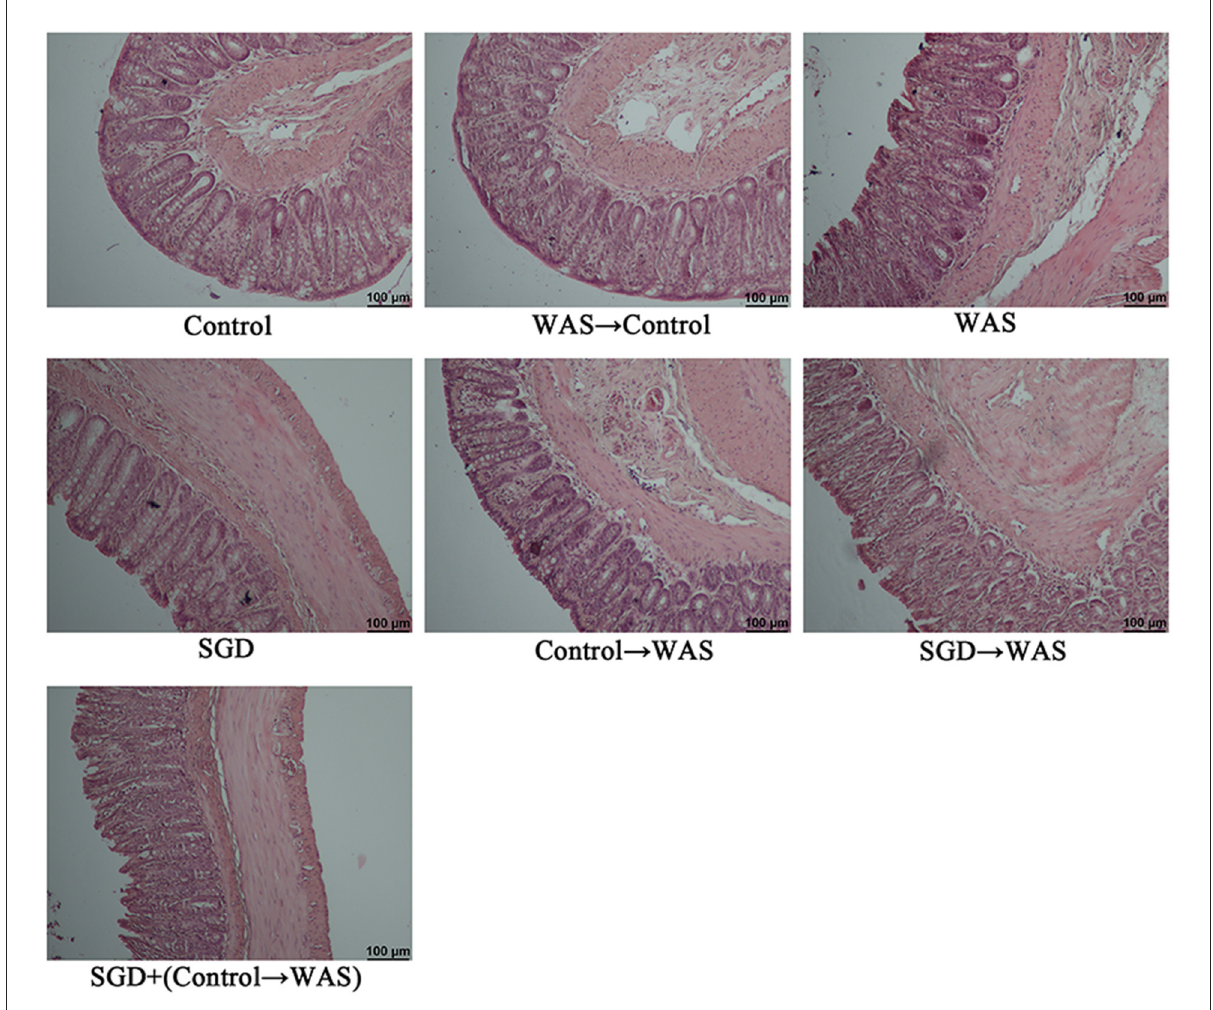
FIGURE2 Histopathological examination of colon in rats.